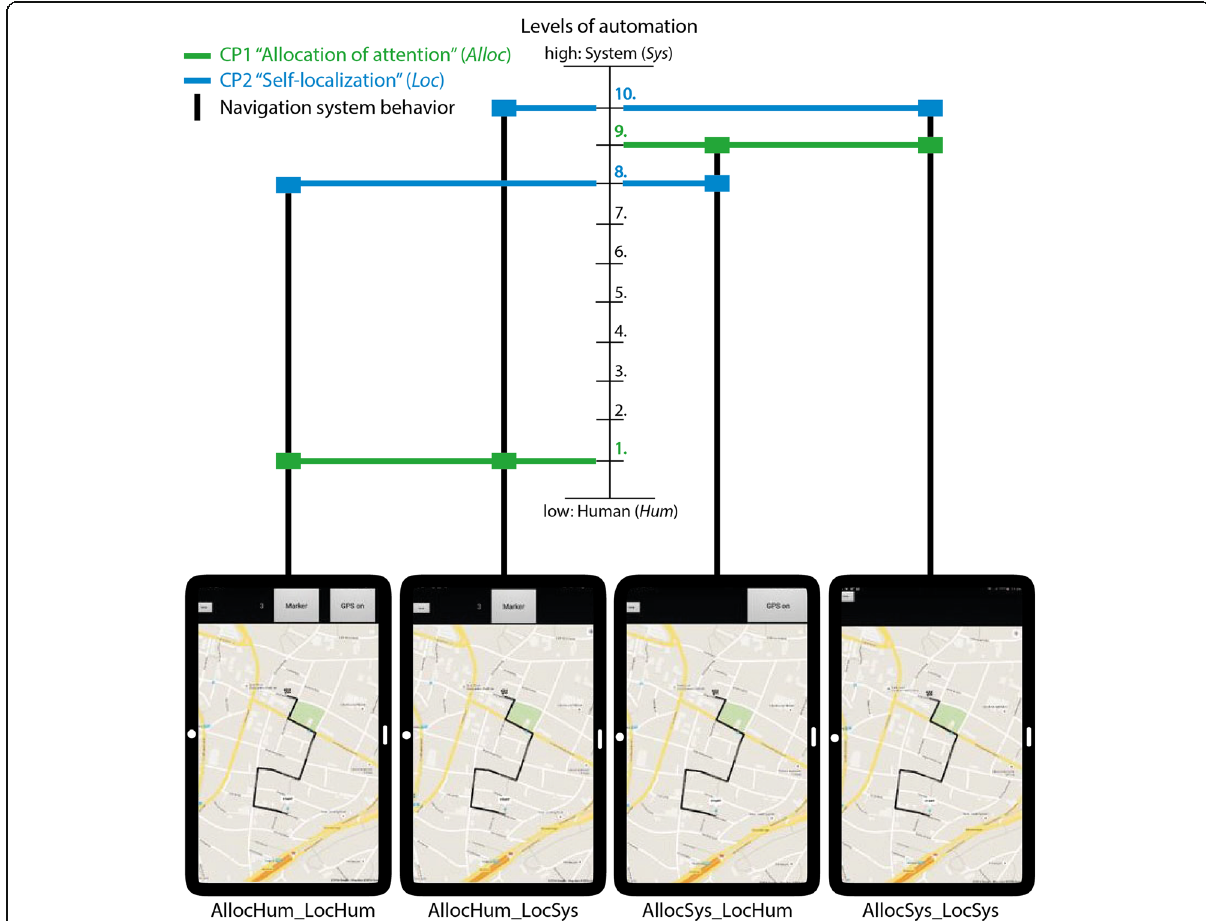
Fig. 3 Four navigation system interface designs with varying navigation system behavior in terms of a combination of two cognitive processes ( CP ): allocation of attention ( Alloc ; green ) and self-localization ( Loc ; blue ). Each cognitive process involves either higher active participation from the human side (low level of automation; Hum ) or higher system assistance (high level of automation; Sys ). The figure illustrates for each navigation system design how the implemented processes map to the levels of automation of Parasuraman et al. (2000) (Fig. 1). The further up a horizontal bar is, the higher the level of automation. Background map is from Google Maps API (© 2016